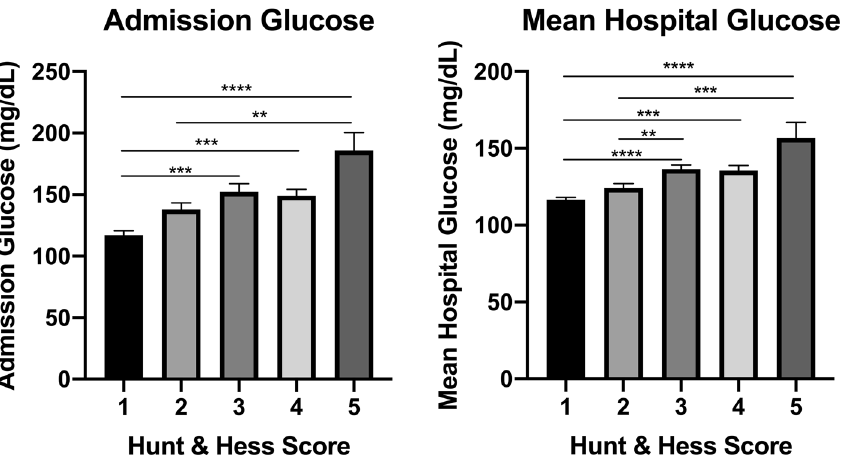
Figure 1. The effect of aneurysmal subarachnoid hemorrhage severity on mean admission day glucose (left) and mean hospital glucose (right). Asterisks indicate post-hoc significance among groups. **p < 0.01, ***p < 0.001, ****p < 0.0001.